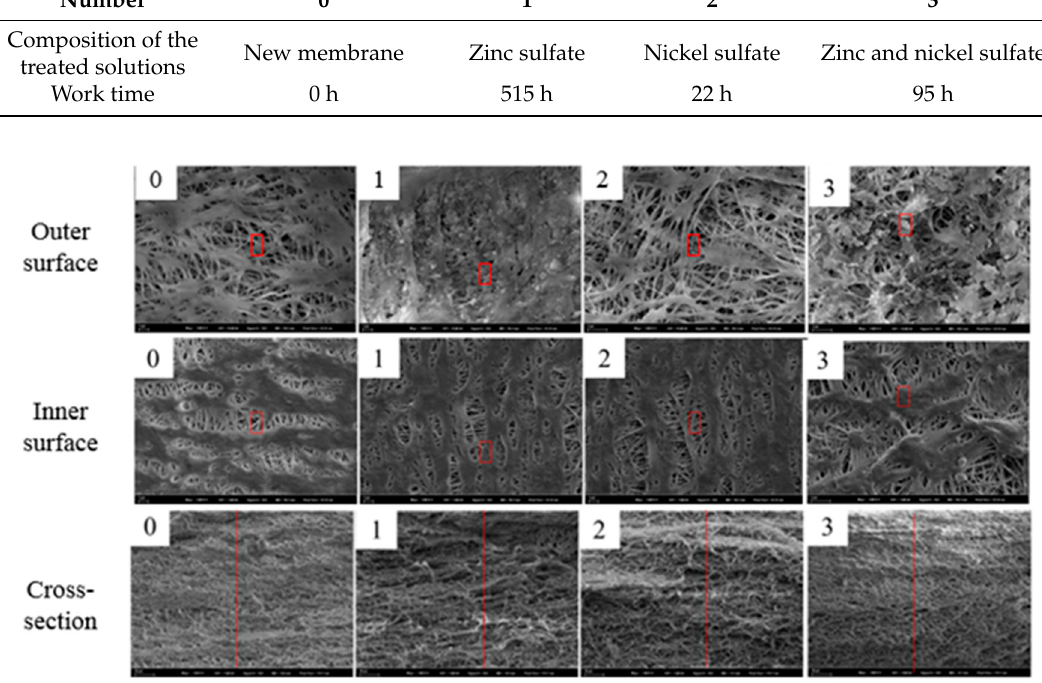
Figure 11. Morphologies of the membrane outer surface, inner surface, and cross-section. ( 0 ) new membrane; ( 1 ) zinc sulfate system; ( 2 ) nickel sulfate system; ( 3 ) mixed system. Table 4. Information of the studied membranes.